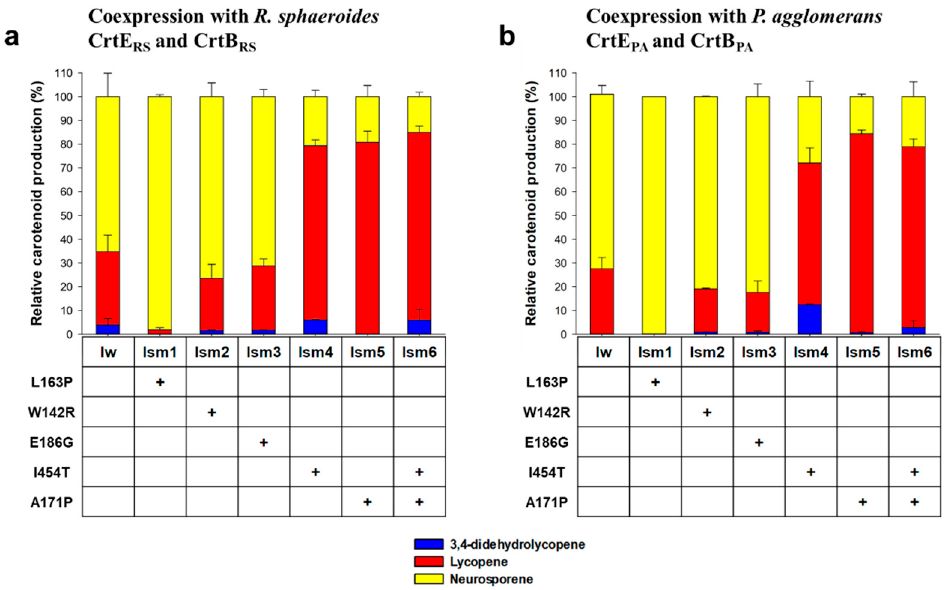
Figure 3. Relative carotenoid profiles in E. coli strains coexpressing site-directed mutant CrtI RS with ( a ) the R. sphaeroides CrtE RS and CrtB RS and ( b ) the P. agglomerans CrtE PA and CrtB PA . Blue, red, and yellow bars represent 3,4-didehydrolycopene, lycopene, and neurosporene, respectively. Iw refers to a wild-type CrtI RS . + symbol indicates the amino acid change in the mutant CrtI. Data are expressed as the mean ± SD.